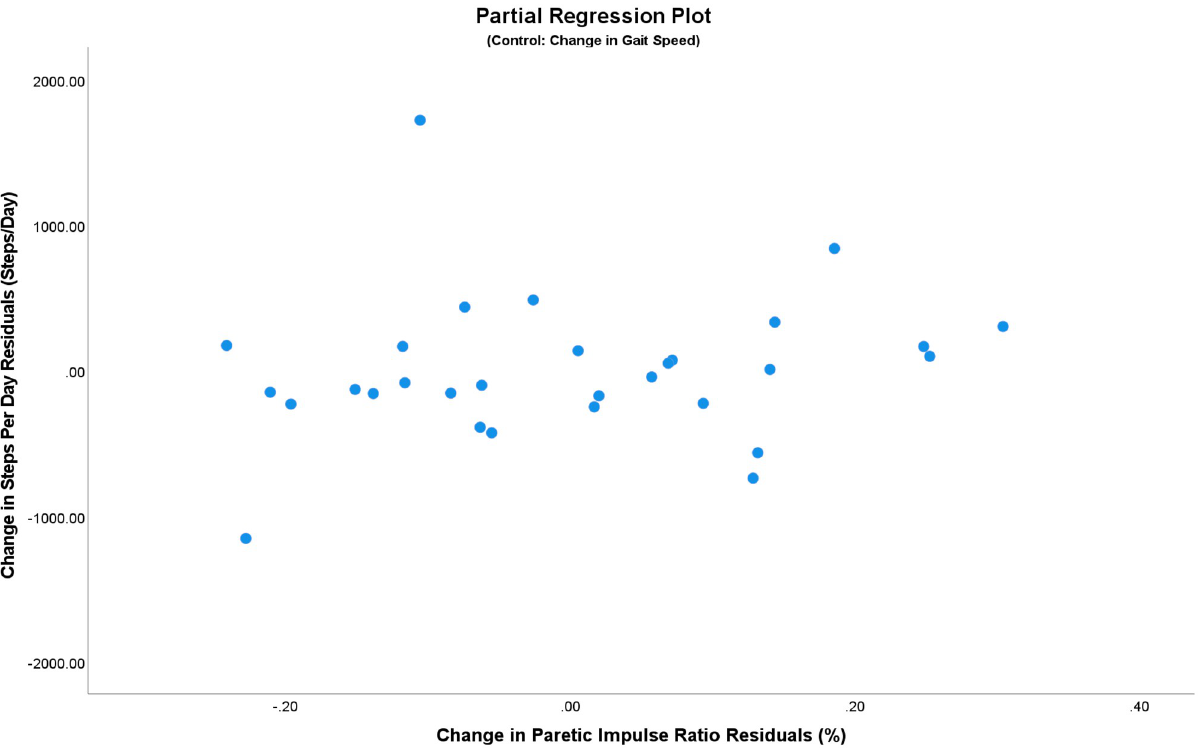
Fig 2. Partial regression residual plot of change in average steps per day against change in paretic impulse ratio, controlling for change in comfortable gait speed. Despite the two apparent outliers in the left upper and lower quadrants, their removal does not change the results.